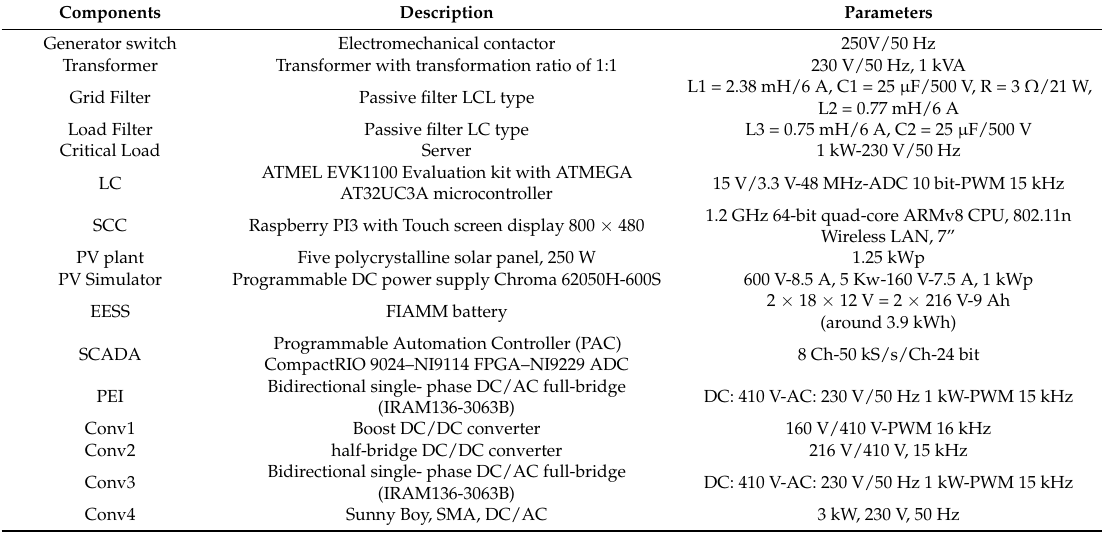
Table 2. Description and data of the Smart User Network (SUN) components installed at the pilot site.